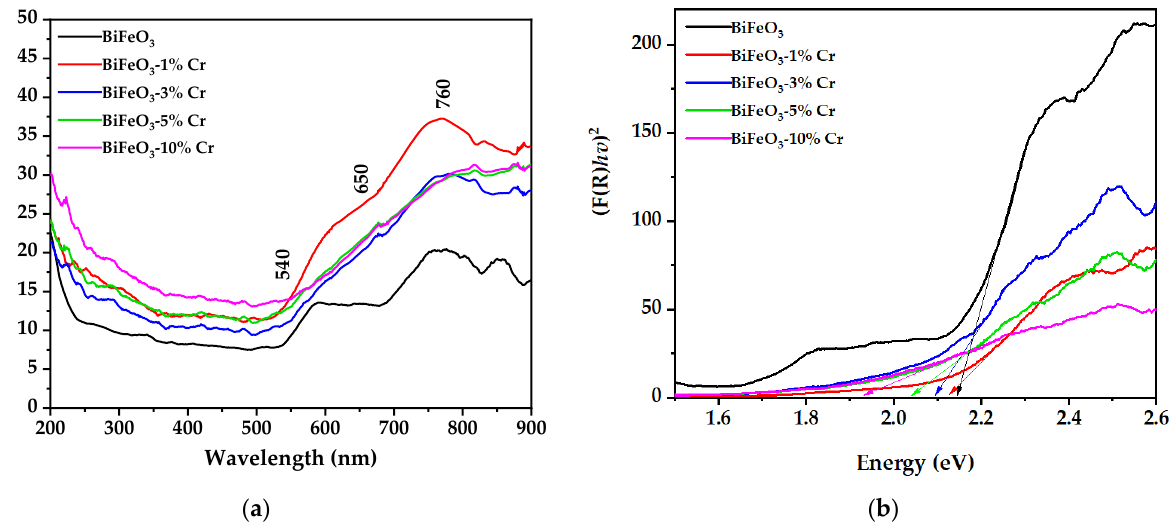
Figure 3. ( a ) UV-visible diffuse reflectance spectra of pure and Cr-doped BiFeO 3 and ( b ) the Kul- beka – Munk plot to calculate the energy bandgap.